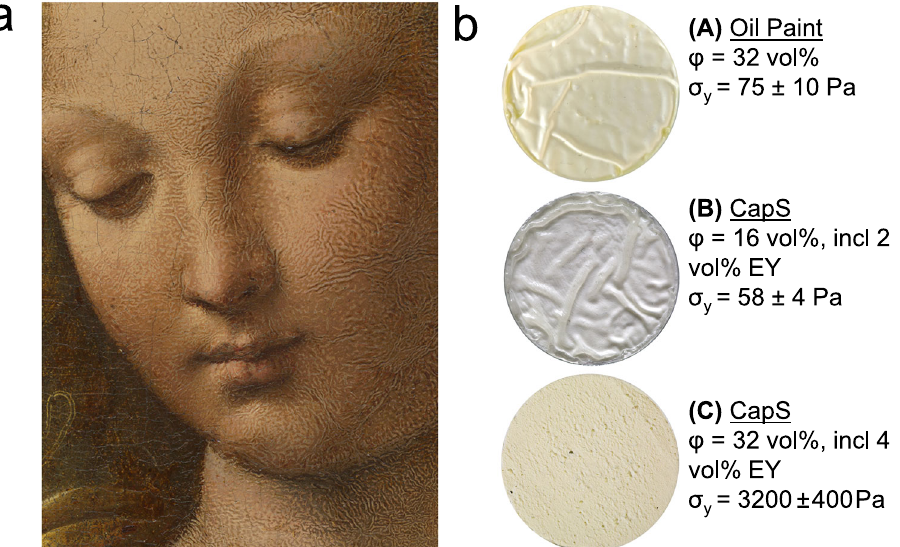
Fig. 7 | Wrinkling and yield stress of paints. a Detail of Mary ’ s face displaying wrinkling of the fl esh paint in Leonardo da Vinci ’ s Madonna of the Carnation , c. 1475,Inv.No.7779,62×48.5cm,©BavarianStatePaintingCollections,Munich,the whole painting is shown in Supplementary Fig. 22. b Photographs of LW paint